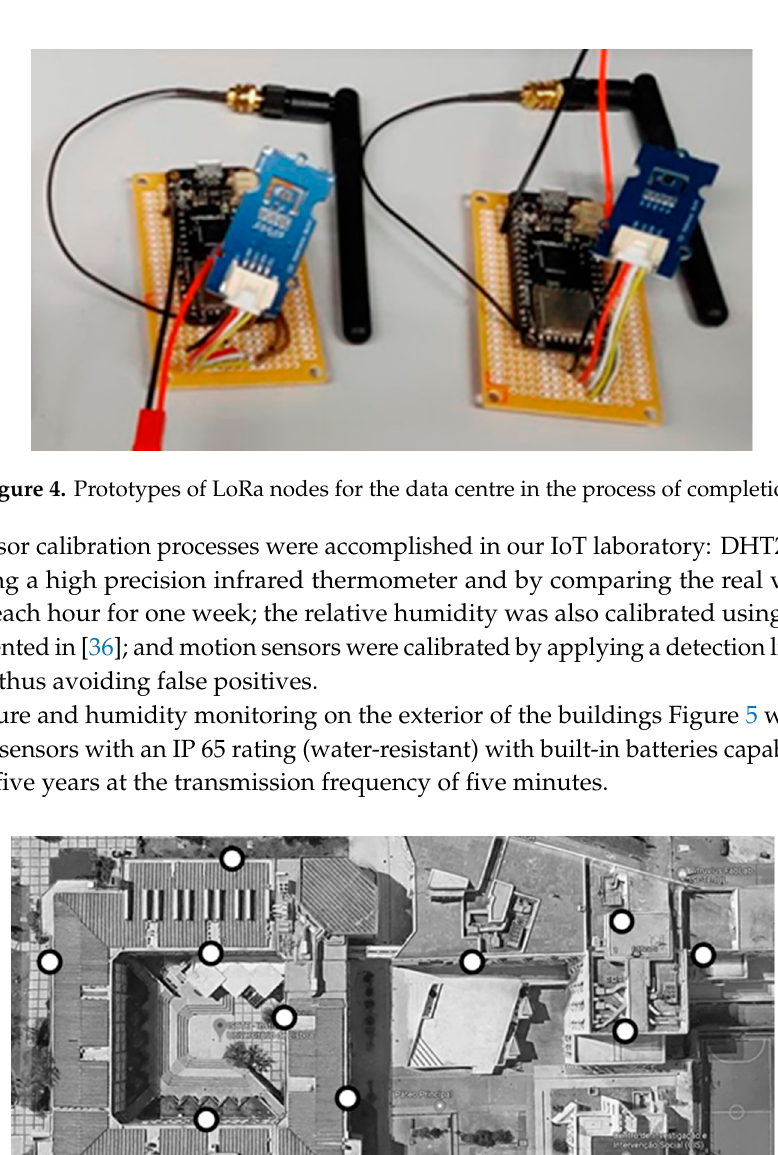
Figure 3. Box drawn with AutoCAD and printed in lactic polyacid (PLA) at the ISCTE-IUL FabLab.